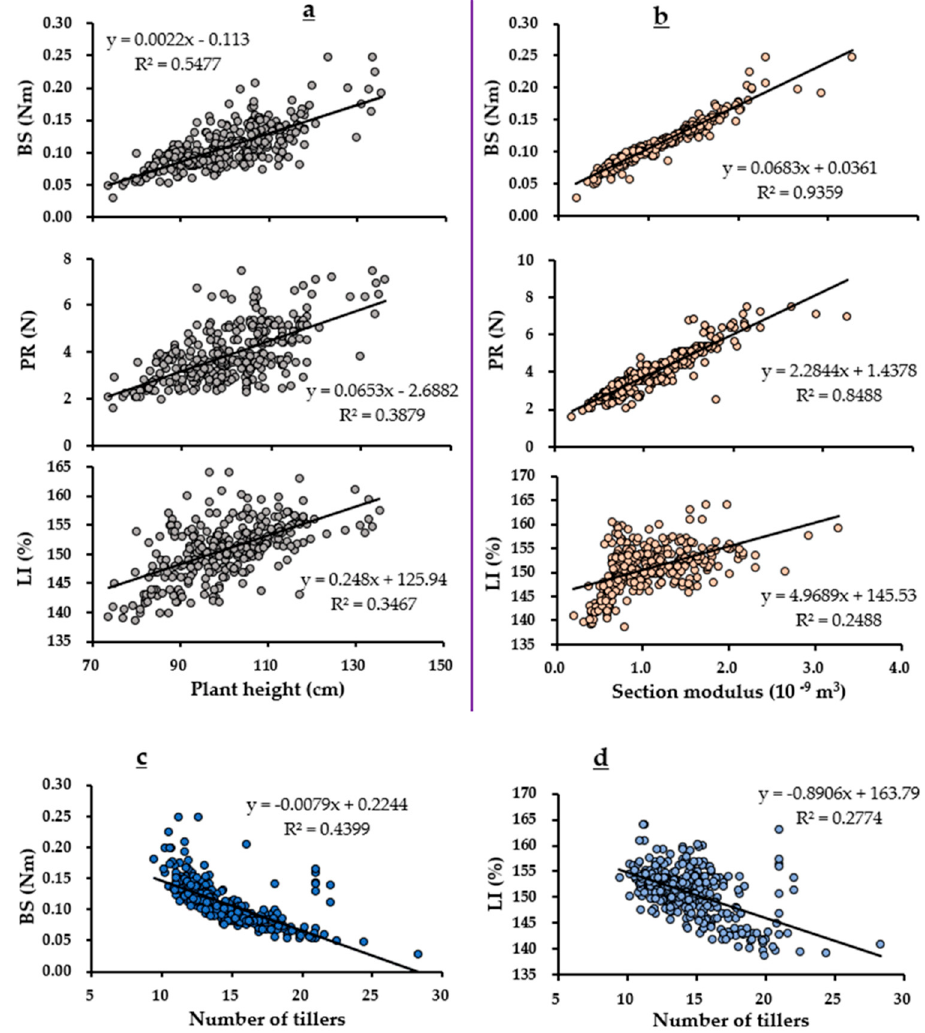
Figure 5. Bivariate analysis showing the relationship of the traits (320 genotypes): ( a ), the relationship of plant height with lodging index (LI), pushing resistance (PR) and base failure moment (BS); ( b ), the relationship of section modulus with lodging index (LI), pushing resistance and base failure moment; ( c ), relationship between number of tillers and base failure moment; and ( d ), number of tillers versus lodging index.